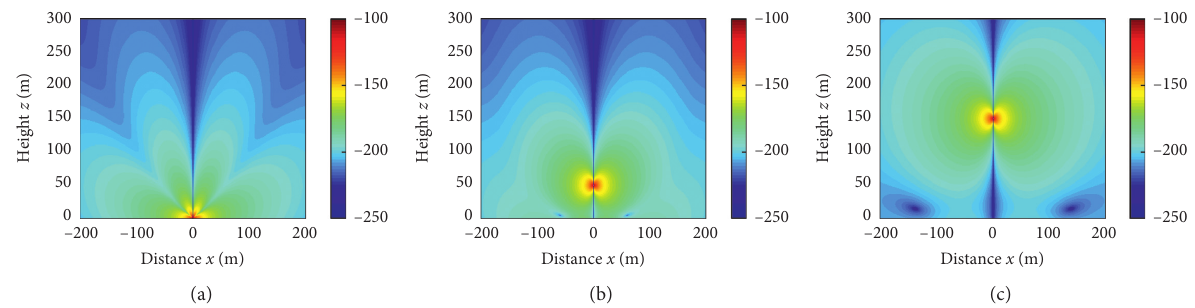
Figure 10: Field distribution of E